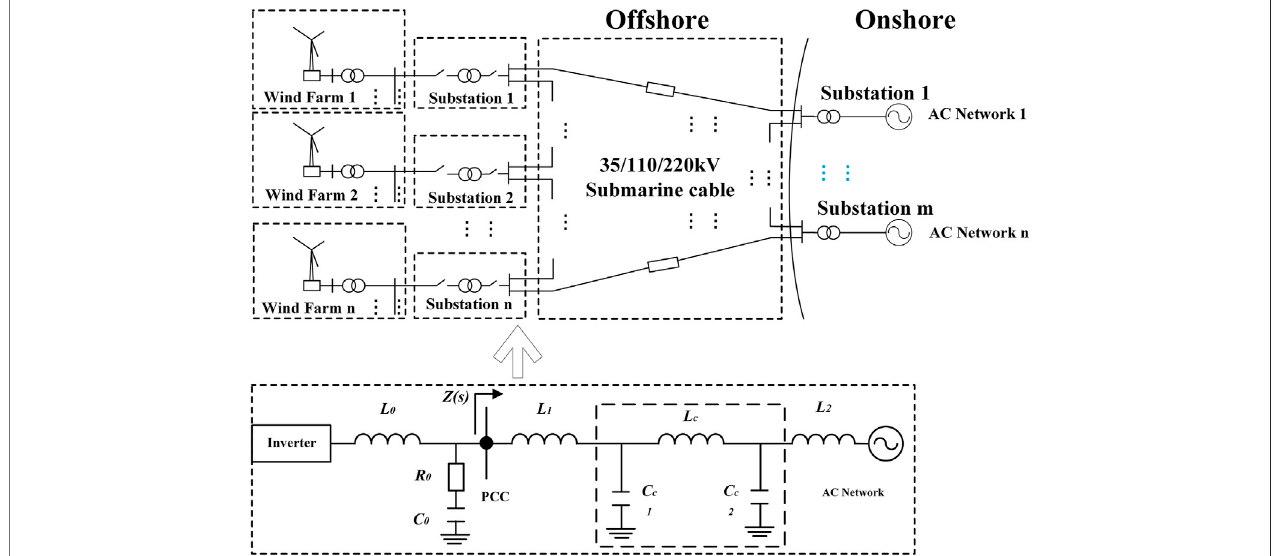
FIGURE 1 | Structural diagram and equivalent circuit of offshore wind power transmission system.